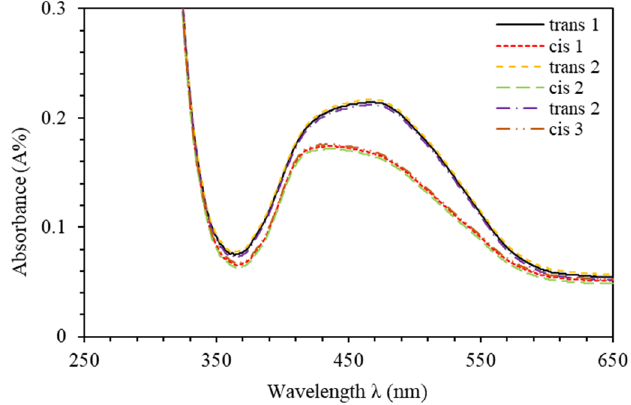
Figure 9. Absorbance spectra of PMMA-BDK-MR polymer composite thin film: Natural trans -case, cis -state after 12 s of UV-366 nm illumination and trans -state after annealing at 90 °C for 1 h.